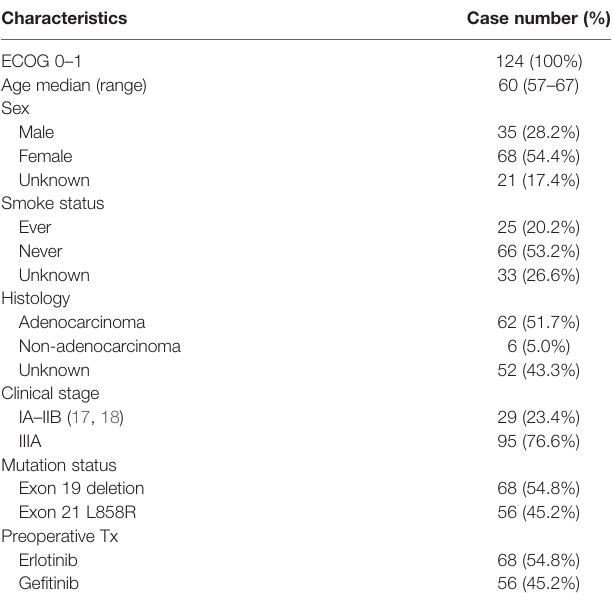
TABLE 2 | Characteristics of included patients (n=124).